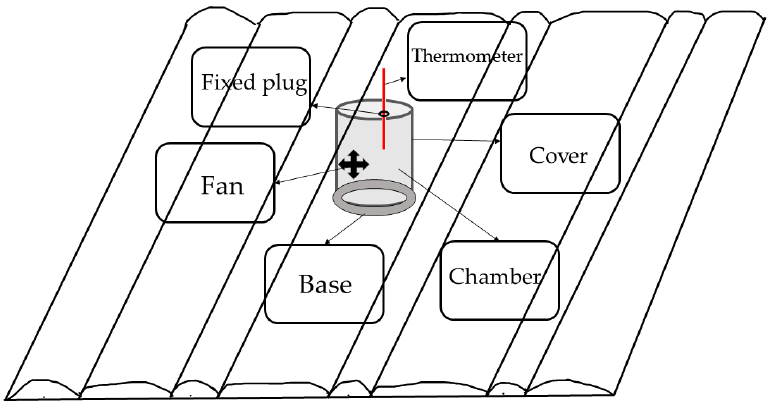
Figure 3. Location and design of a static closed chamber for gas sampling in the experimental plot.